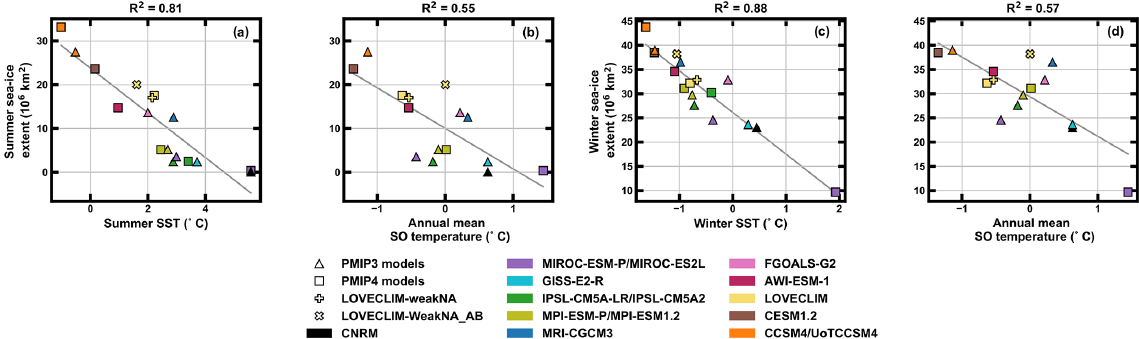
Figure 5. Scatter plots showing the relationship between sea-ice, SO SST (averaged over 50–75 ◦ S) and SO temperature (averaged over 50–75 ◦ S and 0–5500m depth) in all experiments. Panels (a) and (b) show the relationship for austral summer and panels (c) and (d) show the relationship for austral winter.